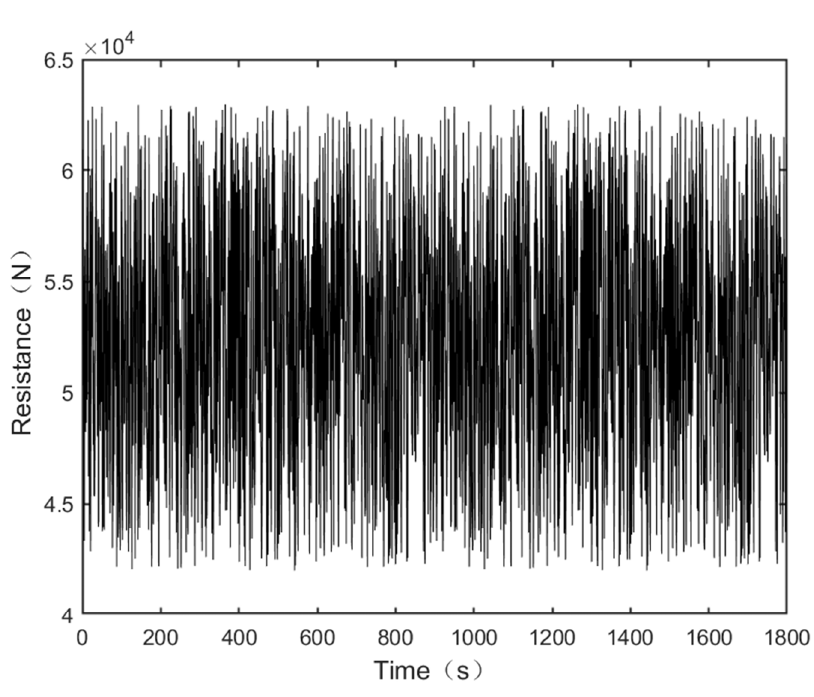
Figure 17. Resistance of plowing operation.